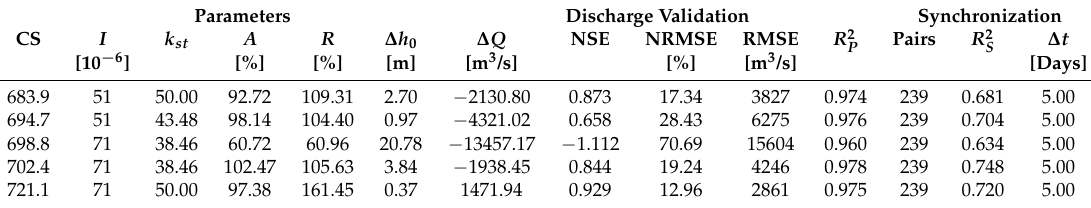
Estimated Parameters (left), discharge validation results (center), and observations synchronization statistics (right) at Vicksburg using combined altimetry data from E3, J1, and S4. A and P are given as percentage and h 0 as deviation of the respective in situ data. The synchronization statistics shows the resulting number of surface area and water level observation pairs, the area-height correlation coefficient R 2 , and the average time ∆ t between the synchronized observations. S